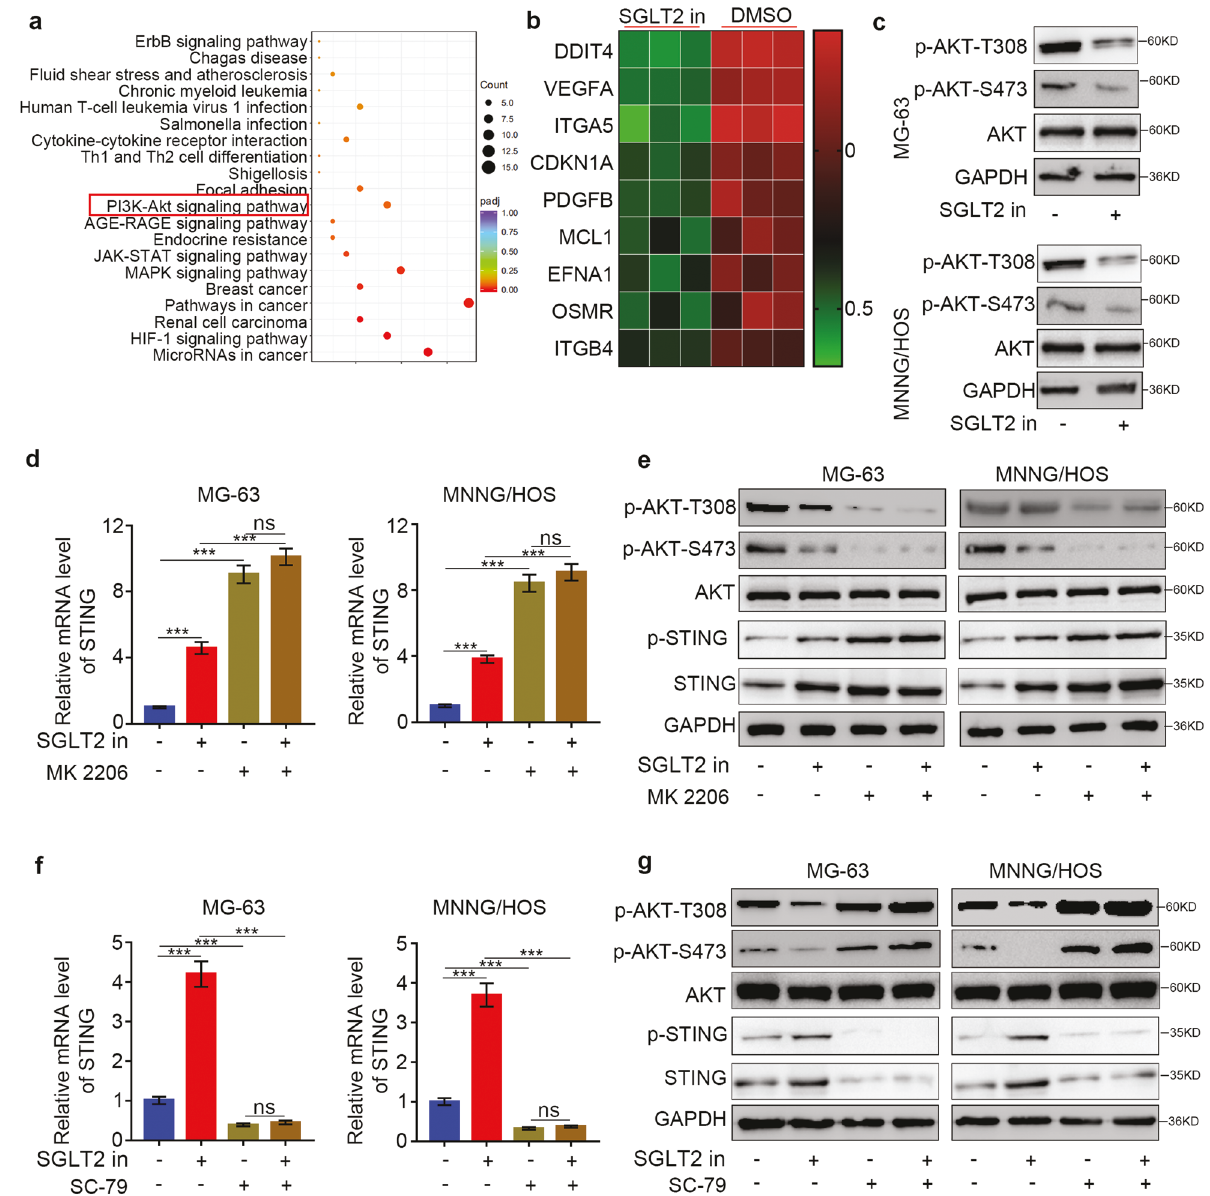
Fig. 7 SGLT2 inhibitor increased the expression level of STING via repressing the AKT pathway in osteosarcoma. a Dot plot of the KEGG enrichment pathways in the SGLT2 inhibitor treatment group. b Heatmap of the SGLT2 inhibitor treatment-related genes that participated in the PI3K-AKT pathway in MNNG/HOS cells. c Western blot analysis of the protein expression levels of AKT and p-AKT in MG-63 and MNNG/HOS cell lines treated with canagli fl ozin (1 uM) for 24 h. GAPDH served as an internal reference. RT-PCR analysis ( d ) and Western blot analysis ( e ) of the mRNA and protein expression levels in MG-63 and MNNG/HOS cell lines treated with canagli fl ozin (1 uM), MK2206 (10 μ M), or the combination of canagli fl ozin (1 uM) and MK2206 (10 μ M). Data are presented as the mean ± SD of three independent experiments (ns not signi fi cant; *** p < 0.001). RT-PCR analysis ( f ) and Western blot analysis ( g ) of the mRNA and protein expression levels of speci fi c genes in MG- 63 and MNNG/HOS cell lines treated with canagli fl ozin (1 uM), SC-79 (20 μ M), or the combination of canagli fl ozin (1 uM) and SC-79 (20 μ M) for 24 h. Data are presented as the mean ± SD of three independent experiments (ns not signi fi cant; *** p <